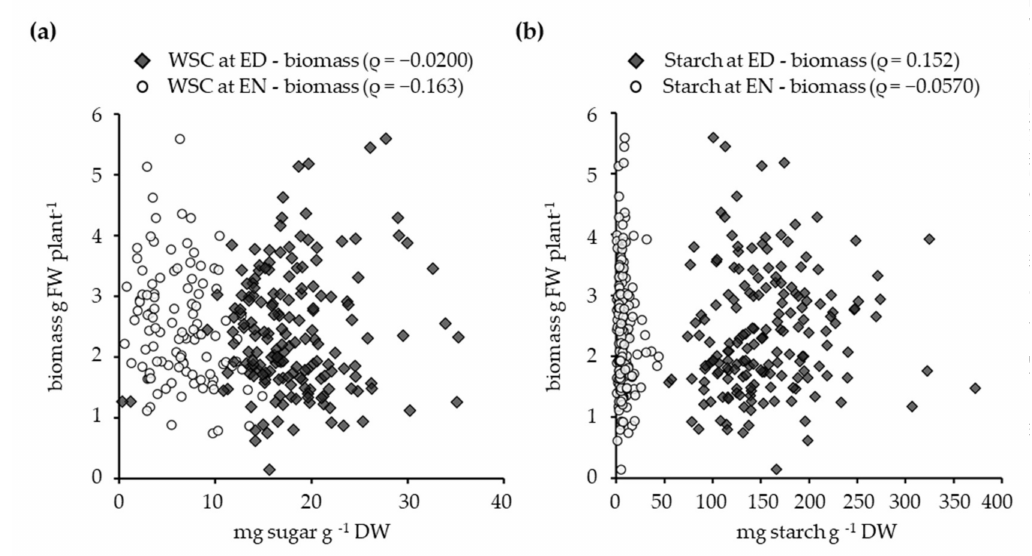
Figure 5. The relationship between WSC content, starch content, and biomass in 185 individual genotypes sampled at ED and at EN. ( a ) The relationship between combined WSC content at ED and EN and biomass; ( b ) the relationship between starch content at ED and EN and biomass. The corresponding p -values to the Spearman-rank correlation coefficients ( (cid:36) ) are indicated in the text. Measurements for glucose, fructose, sucrose, and starch content were the same as described in Figure